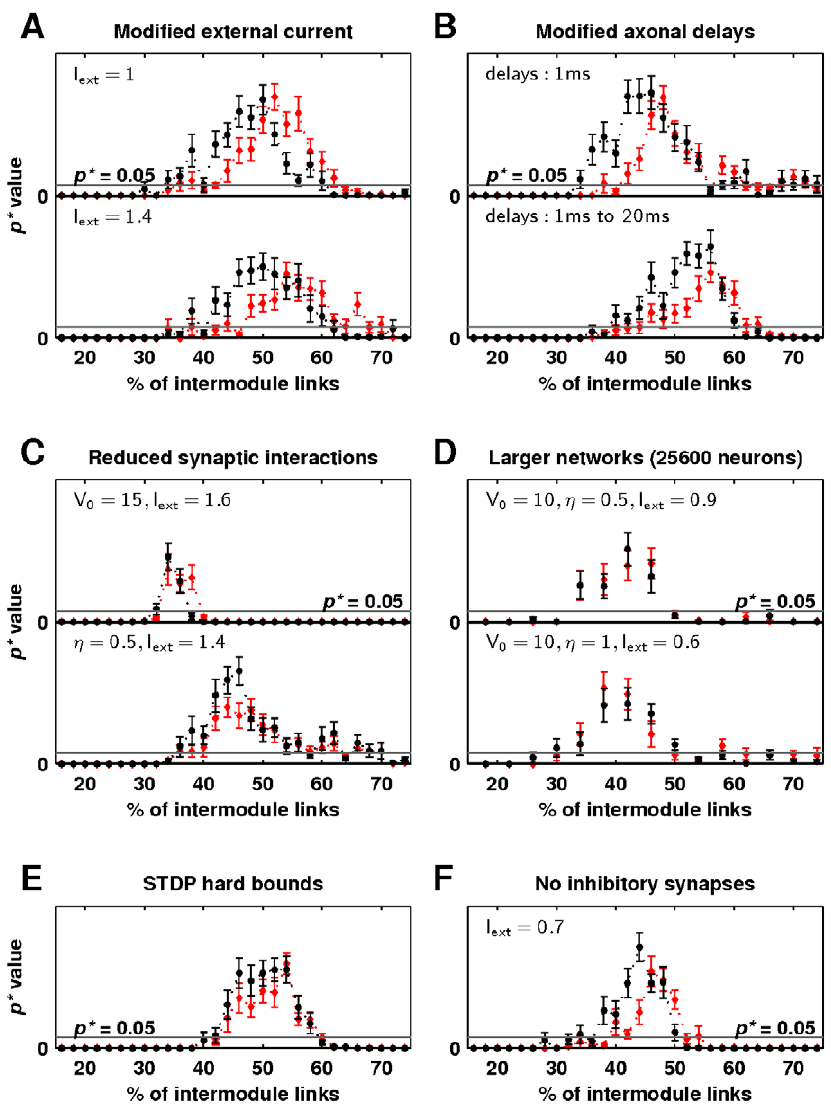
Figure 9. Robustness of self-organized critical network dynamics. Statistical significance of power-law distributions of avalanche sizes (black) and durations (red) as a function of network randomization for the optimal power-law ( a ~ 8 = 3 ) density scaling function associated with (a) changes in external current (default I ext ~ 1 : 2 ), (b) changes in conduction delays (default delays are uniformly distributed between 1 ms and 10 ms ), (c) weaker postsynaptic response (default V 0 ~ 20 ) and slower STDP learning rate (default g ~ 1 ) (d) doubling of module size to 200 neurons and network size to 25600 neurons and reductions in postsynaptic response, STDP learning rate and external current (e) changes from soft to hard STDP weight bounds, and (f) removal of inhibitory synapses. Gray lines show the p (cid:3) ~ 0 : 05 threshold for power-law scaling. Error bars represent the standard error of the mean from 20 simulations.